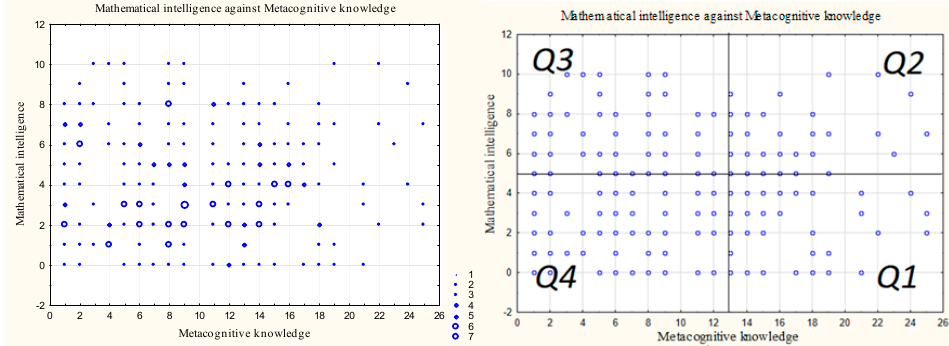
Figure 5. Regular and frequency scatterplots of metacognitive knowledge and mathematical intelligence.